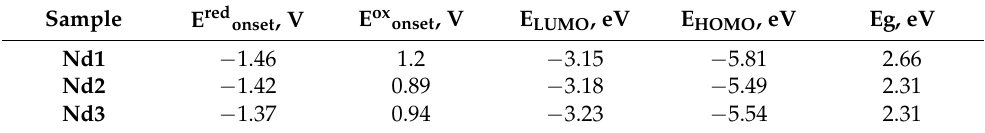
Table 2. Electrochemical properties of the investigated Nd 3+ complexes in HCON(CH 3 ) 2 solution.